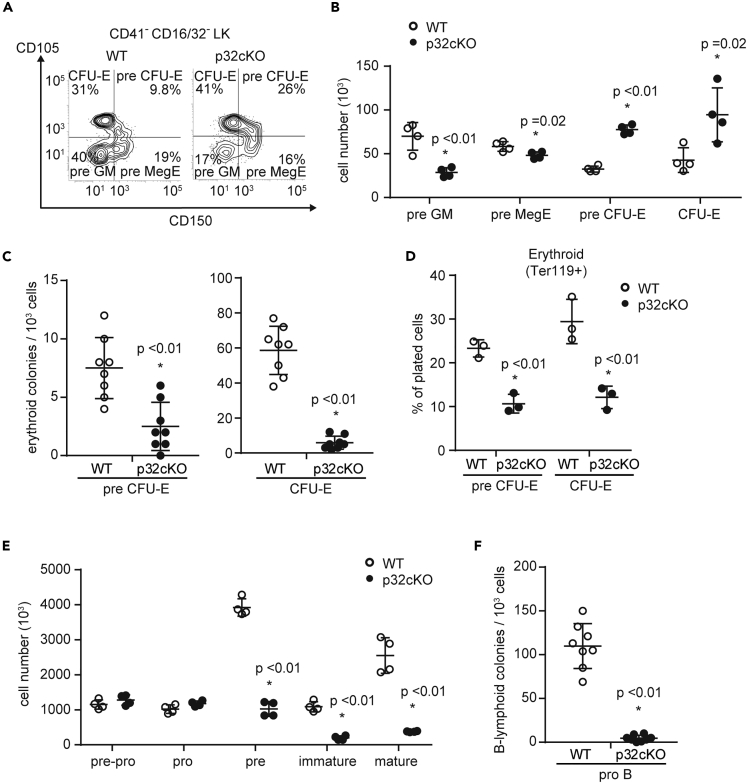
p32/C1qbp Deficiency Prohibits Terminal Differentiation of Erythrocytes and B-Lymphocytes(A) Representative flow cytometry plots of pre-GMs, pre-MegEs, pre-CFU-E cells, and CFU-E cells in bone marrow (BM) of WT and p32cKO mice.(B and E) Numbers of pre-GMs (CD150 – CD105– CD41– CD16/32– LK), pre-MegEs (CD150+ CD105– CD41– CD16/32– LK), preCFU-Es (CD150+ CD105+ CD41– CD16/32– LK), CFU-Es (CD150– CD105+ CD41– CD16/32– LK) (B) and pre-pro- (B220+ CD19– CD43+ IgM–), pro- (B220+ CD19+ CD43+ IgM–), pre- (B220+ CD19+ CD43– IgM–), immature (B220+ CD19+ CD43– IgM+), and mature (B220++ CD19+ CD43– IgM+–) B cells (E) in BM from WT and p32cKO mice.(C and F) Sorted pre-CFU-Es, CFU-Es (C), and pro-B cells (F) from WT and p32cKO mice were plated at low densities (1000 cells/well) in methylcellulose (Stem Cell Technologies, Cat#: M3334 [CFU-E] Cat#: 3630 [CFU pre-B + 25ng/mL SCF]). Erythroid and B-lymphoid colonies were enumerated at day 2 (C) and day 5 (F).(D) Sorted pre-CFU-E and CFU-E cells from WT and p32cKO mice were seeded in liquid culture with cytokines (stem cell factor, IL-3, IL-6, erythropoietin, and thrombopoietin) for 48 hr. The erythroid (Ter119+) lineage potential of sorted preCFU-E and CFU-E cells is shown. Cell numbers in each population were normalized as the percentage of total cells plated per well (% of cells plated). (B–F) Data are shown as means ± SD. ∗p < 0.05 versus WT mice. Data are representative at least three (A–F) independent experiments.See also Figures S2 and S3.